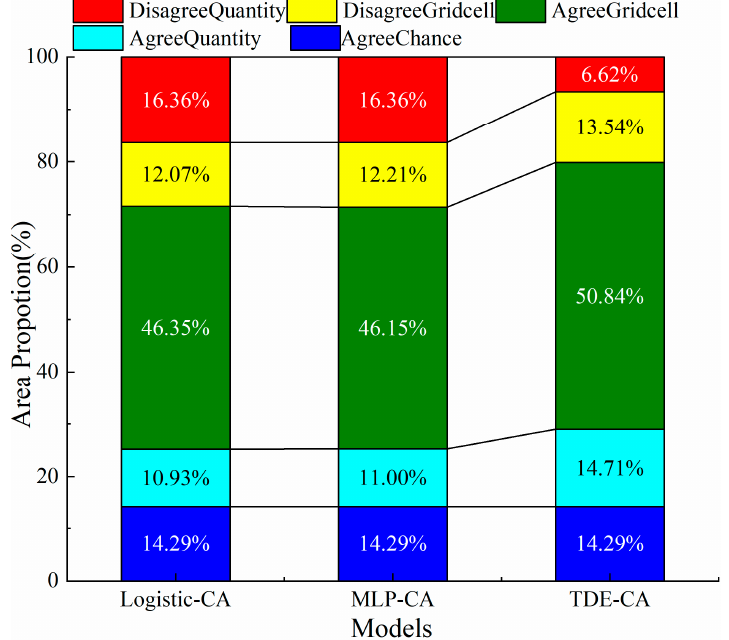
Figure 9. The comparison of the TDE-CA and other models in agreement and disagreement.